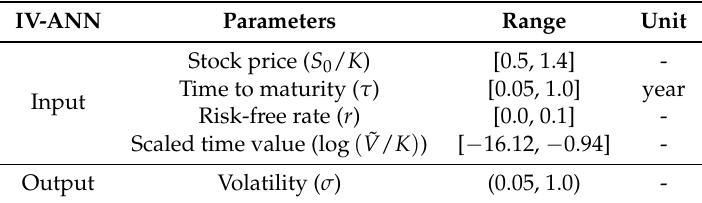
Table 6. Parameter range of data set.